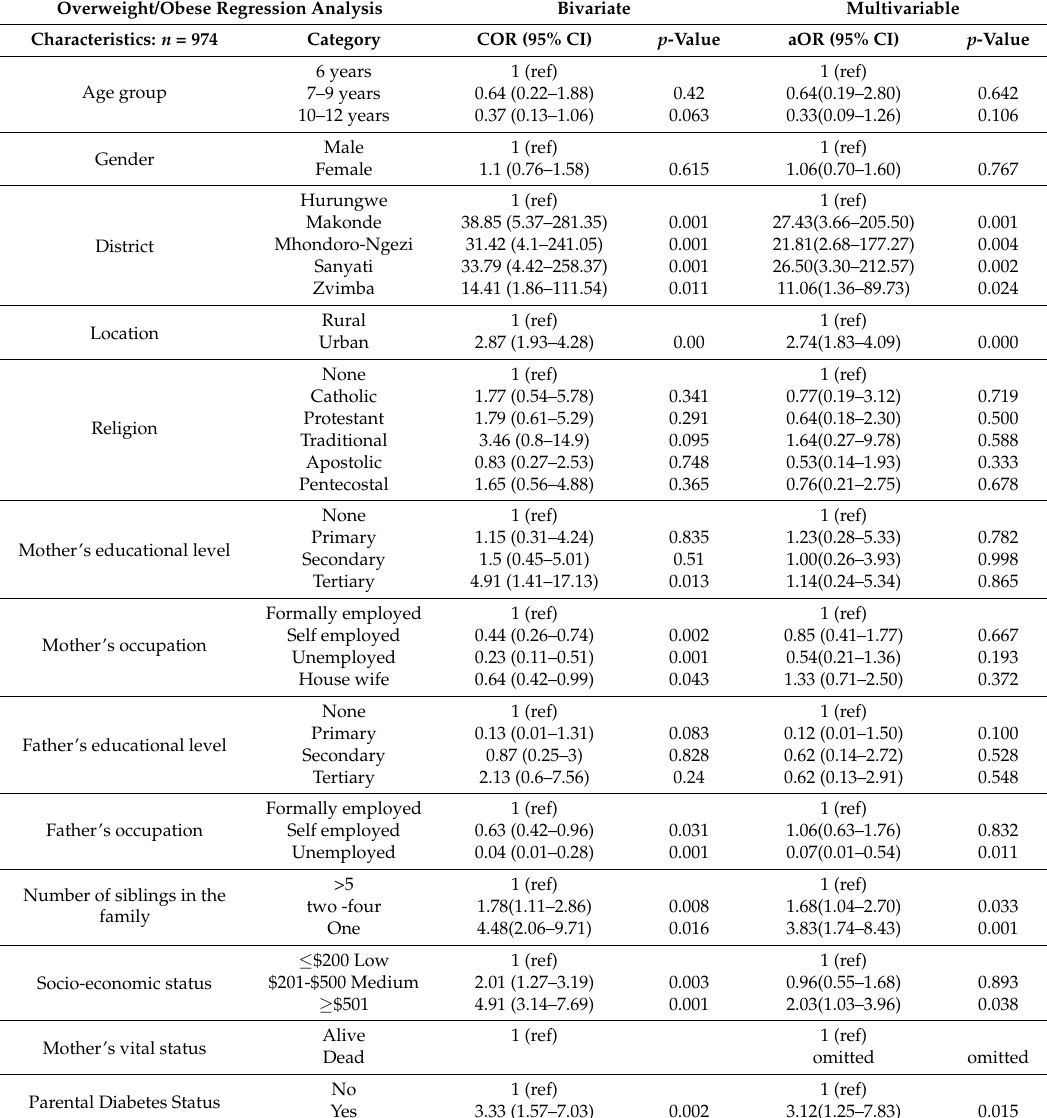
Table 2. Bivariate and multivariable regression analysis of primary school children demographics to analyze risk of overweight/obese, defined from BMI with IOTF (Cole, 2012) and BMI-for-age reference